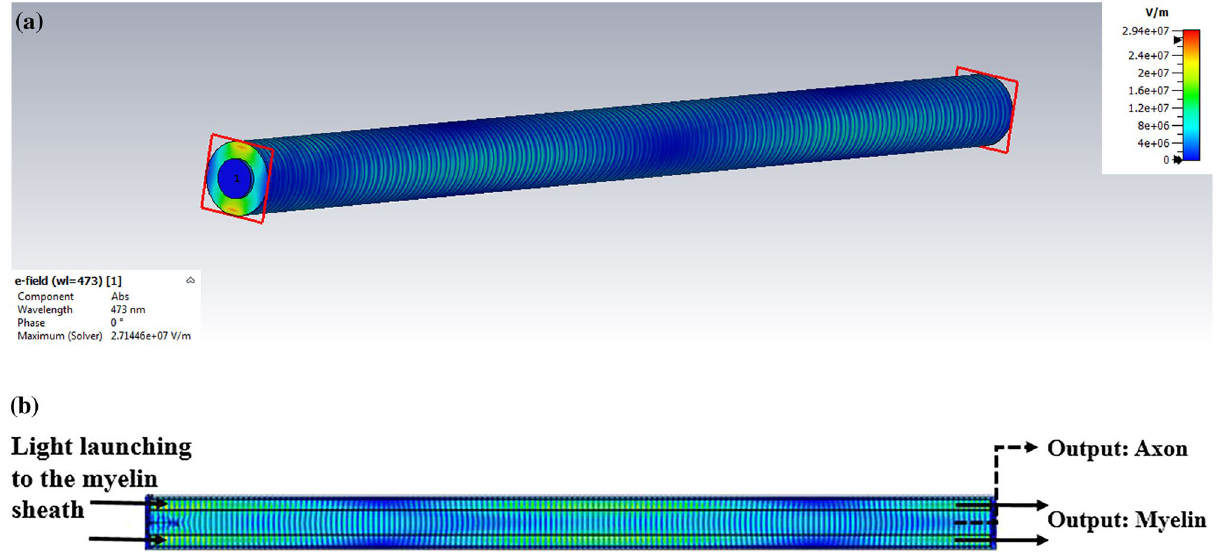
Figure 4. Launching of light to the myelin sheath for g-ratio = 0.7. Distribution of the electric field at ( a ) the transverse and ( b ) the longitudinal cross-sections of the myelinated